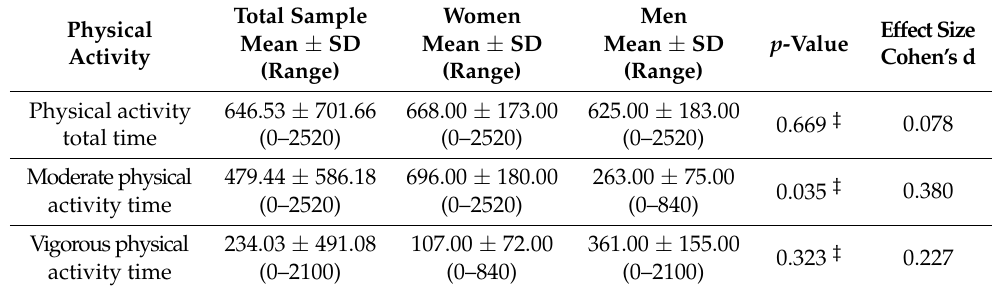
Table 3. Sample physical activity